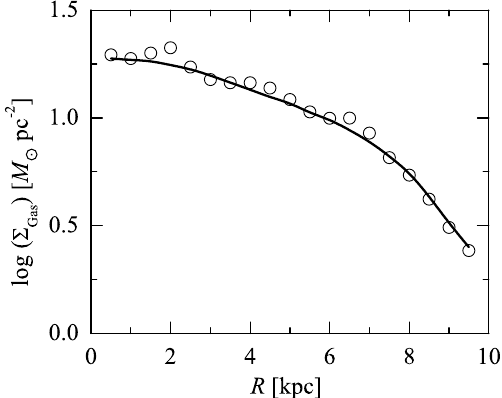
Fig. 2. The profiles of gas surface density. The solid line denotes the average of 30 models; the circles represent observational data from Corbelli (2003).